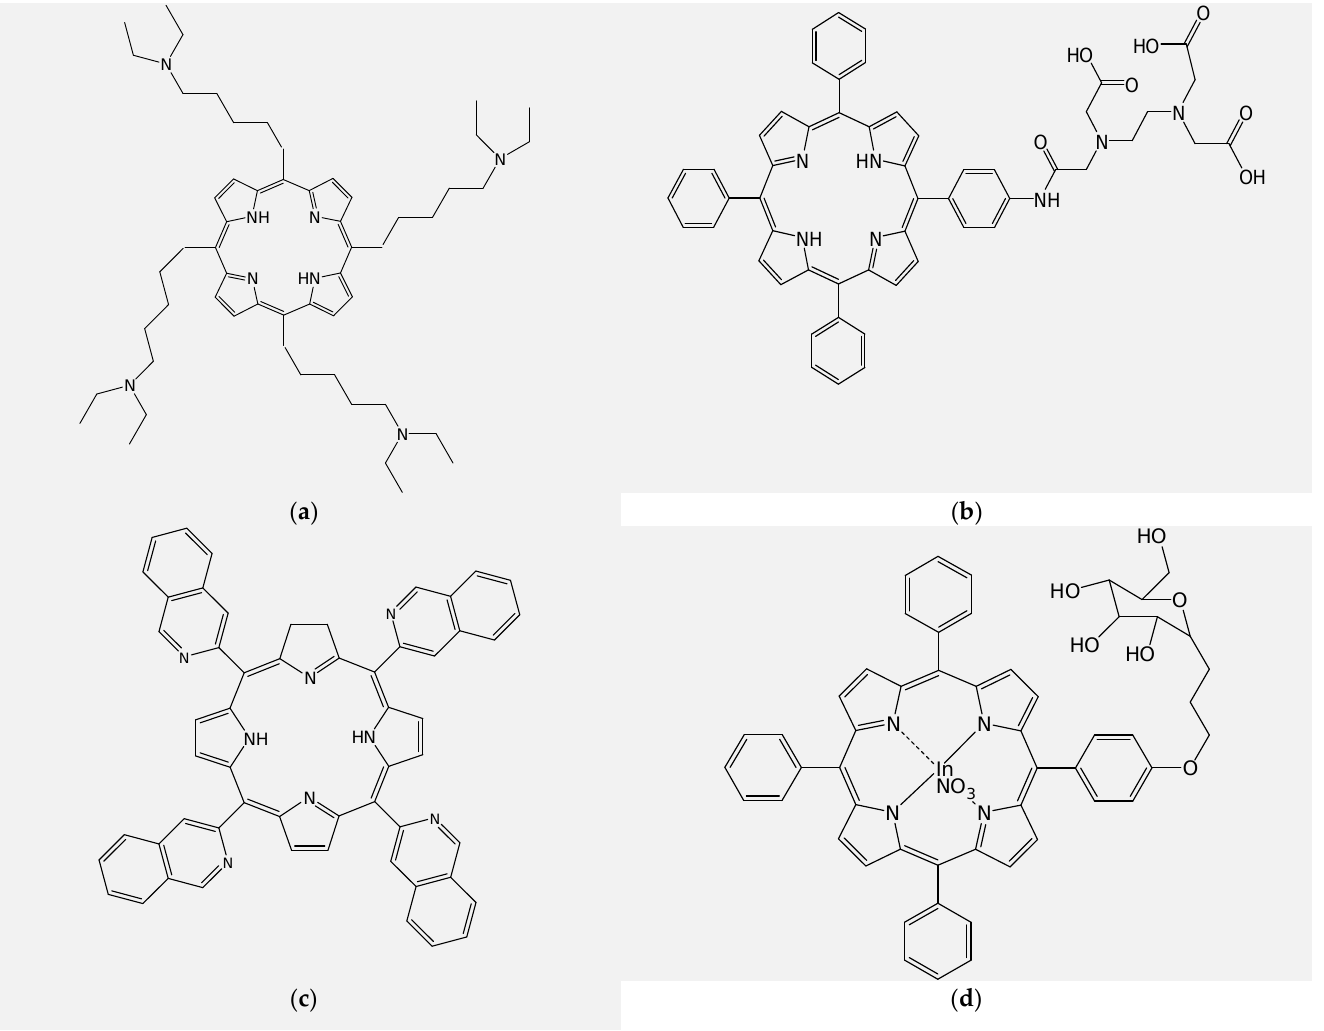
Figure 6. Structures of porphyrin type macrocycles functionalized with fragments of diethylaminopentyl alchol (a) [154], ethylenediaminetetraacetic acid (b) [156], isoquinoline (c) [182], glucopyranoside (d) [157].